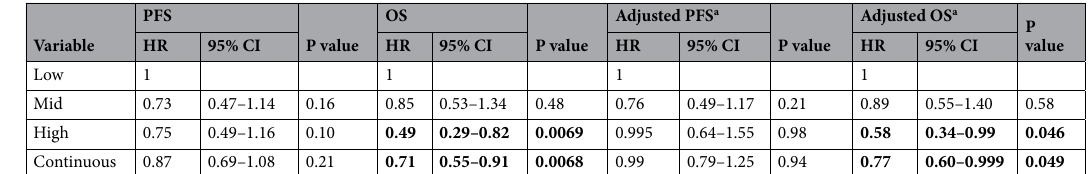
Table 2. Associations of TOPORS-AS1 with ovarian cancer survival. PFS progression-free survival, OS overall survival. a Adjusted for age at surgery, disease stage, tumor grade, and histologic type. Bold indicates p<0.05.